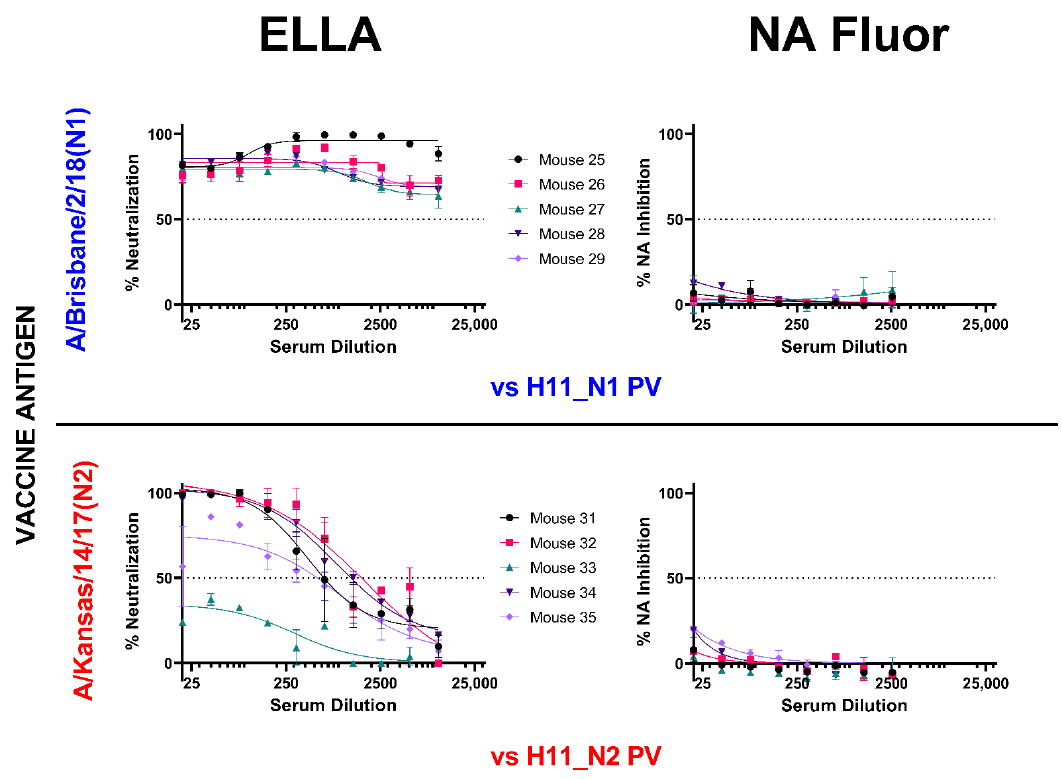
Figure 6. Comparison of inhibition of H11_NA PV by N1 and N2 post-vaccination mouse sera using enzyme-linked lectin assay (ELLA) and NA Fluor™. Sera from mice vaccinated with A/Brisbane/2/18 (N1) (blue) (n = 5) and A/Kansas/14/17 (N2) (red) (n = 5) were diluted two-fold starting from 1:20 for both assays. They were then tested for their ability to inhibit homologous NA subtype PV. Percent NA inhibition is shown as a function of serum dilution. For all plots, each point represents the mean and standard deviation of two replicates per dilution.